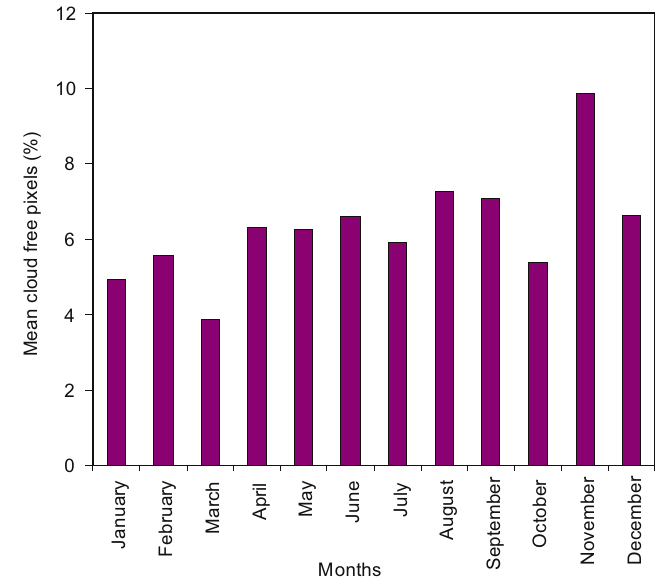
Fig. 6. Mean monthly variations of cloud-free pixels in the